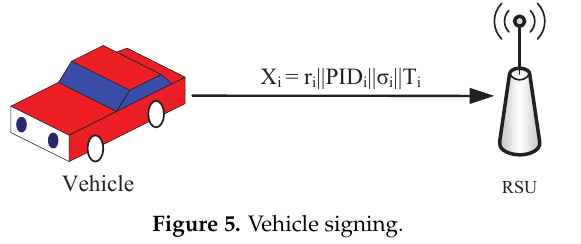
Figure 5. Vehicle